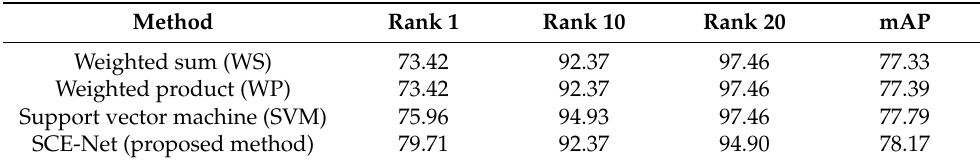
Table 5. Comparisons on the ReID accuracies of the proposed and various score-level fusions with DBPerson-Recog-DB1 (unit: %).